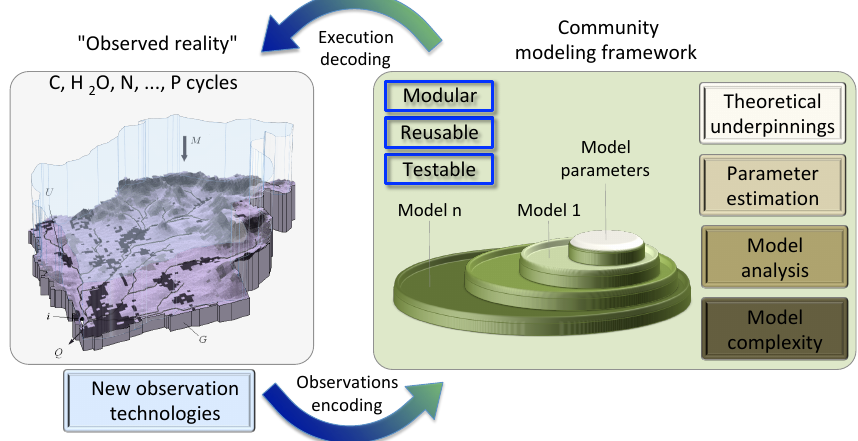
Figure 1. Schematic summarizing some key research priorities to advance the physical realism of process-based hydrologic models. Note that the framework accommodates multiple models (model 1, ..., model